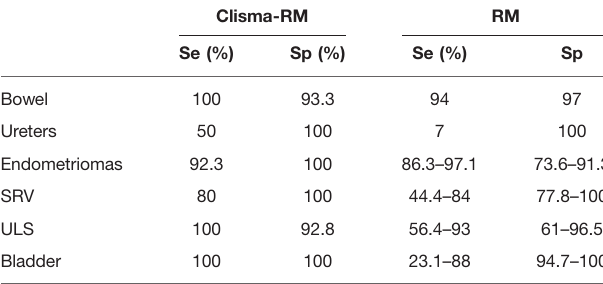
TABLE 2 | Personal casistic vs.